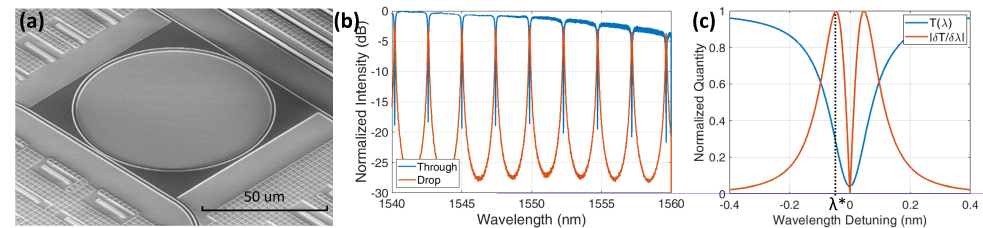
Figure 3. SiPh chip. ( a ) Picture of the MRR: waveguides for Input, Through and Drop are visible; ( b ) Through and Drop spectral response of an exposed MRR immersed in saline solution. ( c ) Modelled Through transfer function T ( λ ) and its slope S i ( λ ) = δ T ( λ ) / δλ